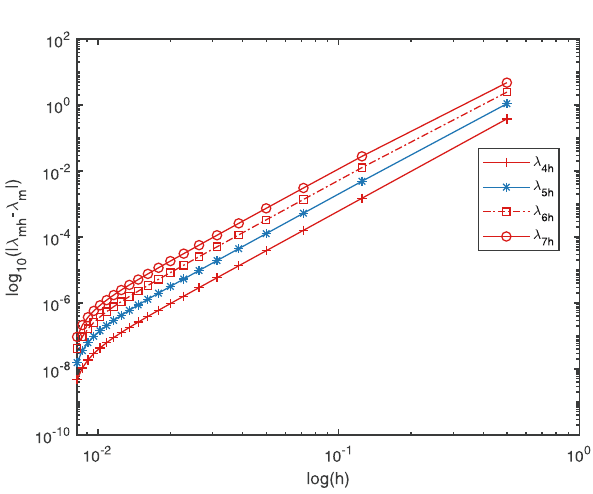
Figure 6: The eigenvalue errors in log - log scale between numerical solutions and the reference solution for = m 4, 5, 6, 7 and = R 1